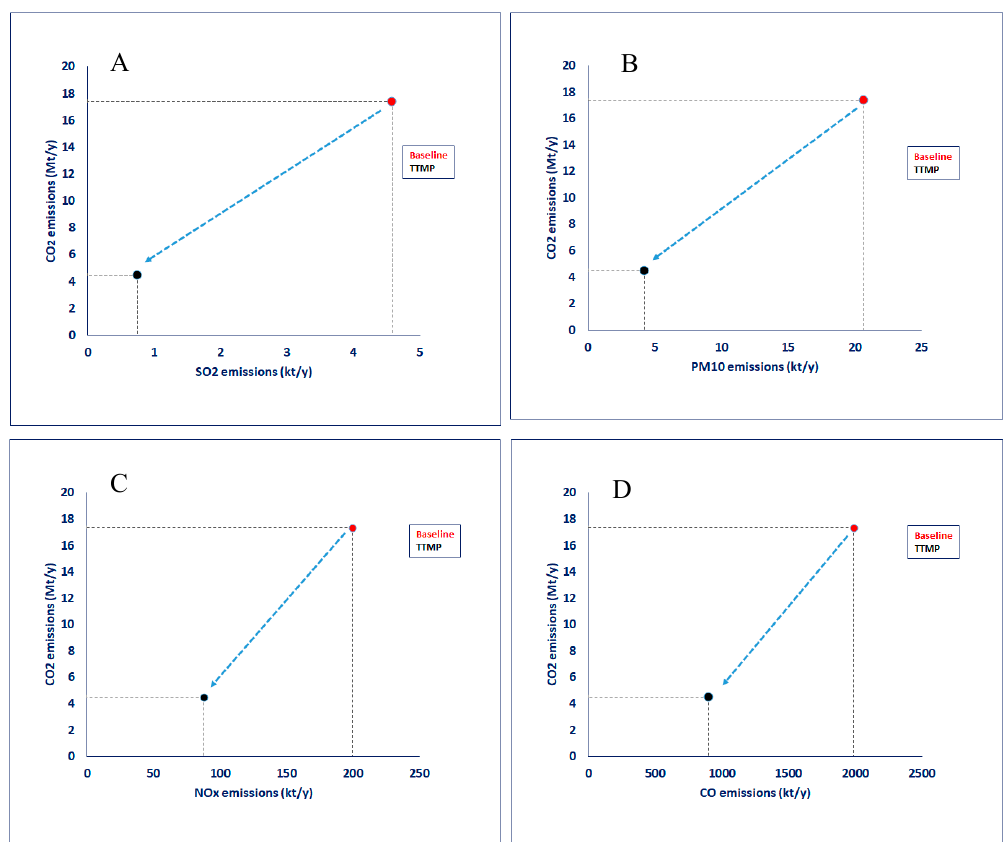
Figure 7. Expected reduction in CO 2 emissions and air pollution from the TTMP in 2030 (A: CO 2 Vs. SO 2 ; B: CO 2 Vs. PM 10 ; C: CO 2 Vs. NOx and D: CO 2 Vs. CO).